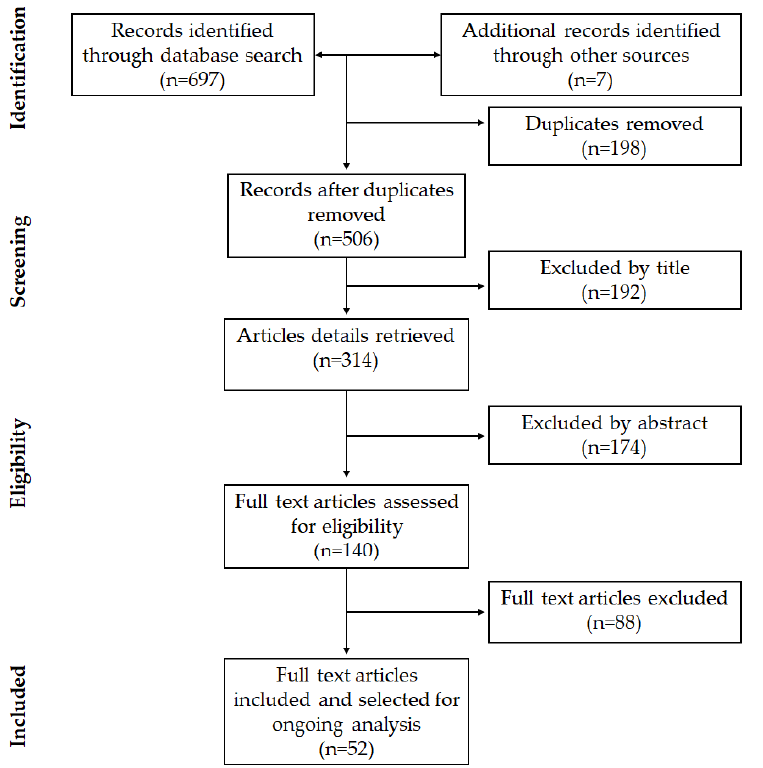
Figure 1. Flow chart for study selection.